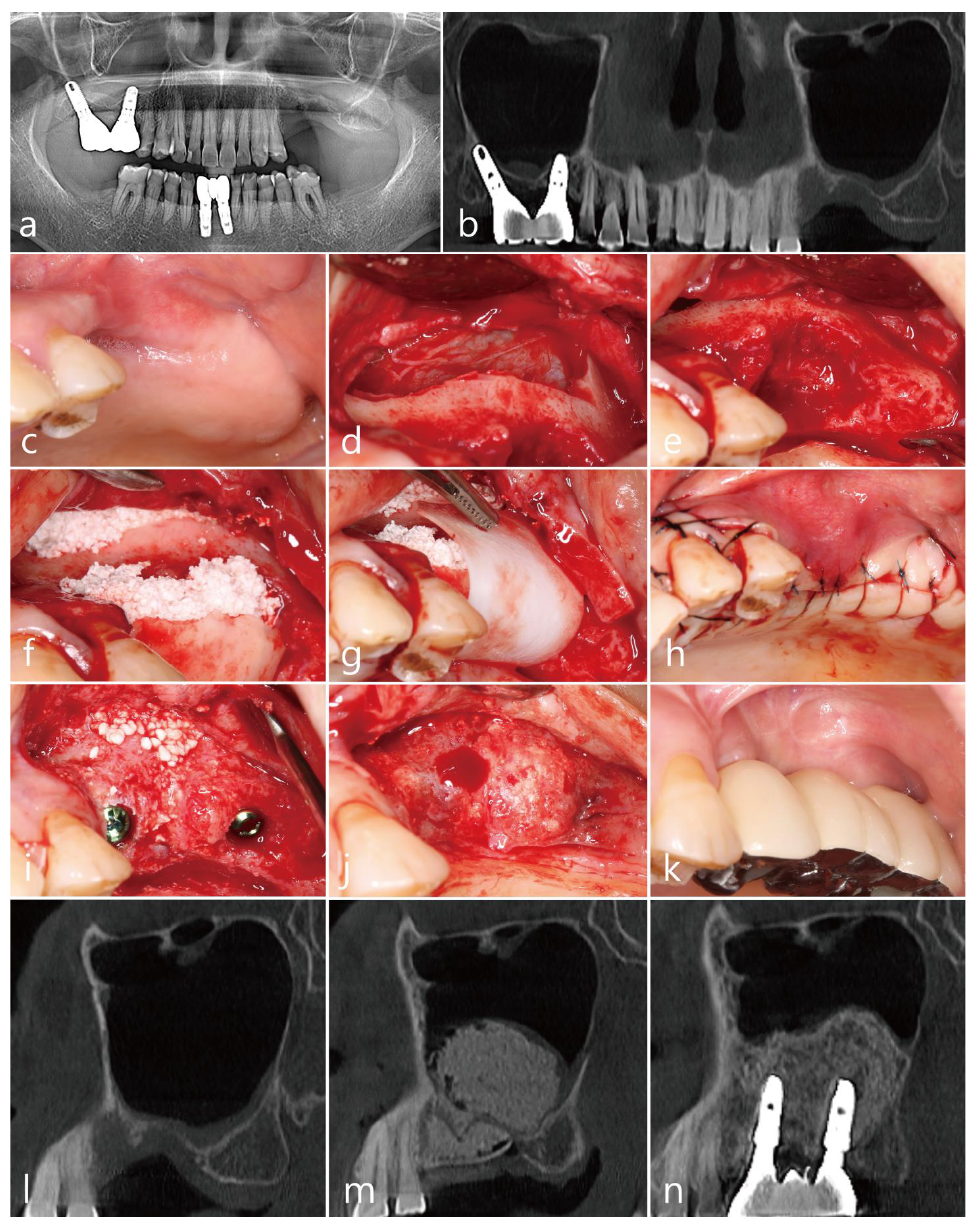
Figure 2. Case 2: ( a ) preoperative panoramic radiograph; ( b ) preoperative panoramic image of the CBCT scan showing a severely resorbed bone defect and a pneumatized maxillary sinus on the left side; ( c ) preoperative clinical view at two months after extraction of the left maxillary second premolar and first molar; ( d ) after reflection of the mucoperiosteal flap, the lateral bony window was obtained; ( e ) thorough debridement was performed to remove inflammatory granulation tissue; ( f ) after maxillary sinus augmentation, an appropriately trimmed lateral bony window was placed on the defect, and the gap was filled with particulate bone graft; ( g ) the grafted site was covered with a collagen membrane; ( h ) the mucoperiosteal flaps were closed with minimal tension; ( i ) implants were placed six months after the surgery, and additional bone grafting was performed at the lateral window site where bone loss had occurred due to the sinus graft infection; ( j ) the uncovering procedure was performed six months after implant placement; ( k ) a prosthesis was delivered two months after the uncovering procedure; ( l ) preoperative sagittal image of the CBCT scan; ( m ) sagittal images of the CBCT taken immediately after surgery; ( n ) sagittal image of the CBCT one year after prosthesis